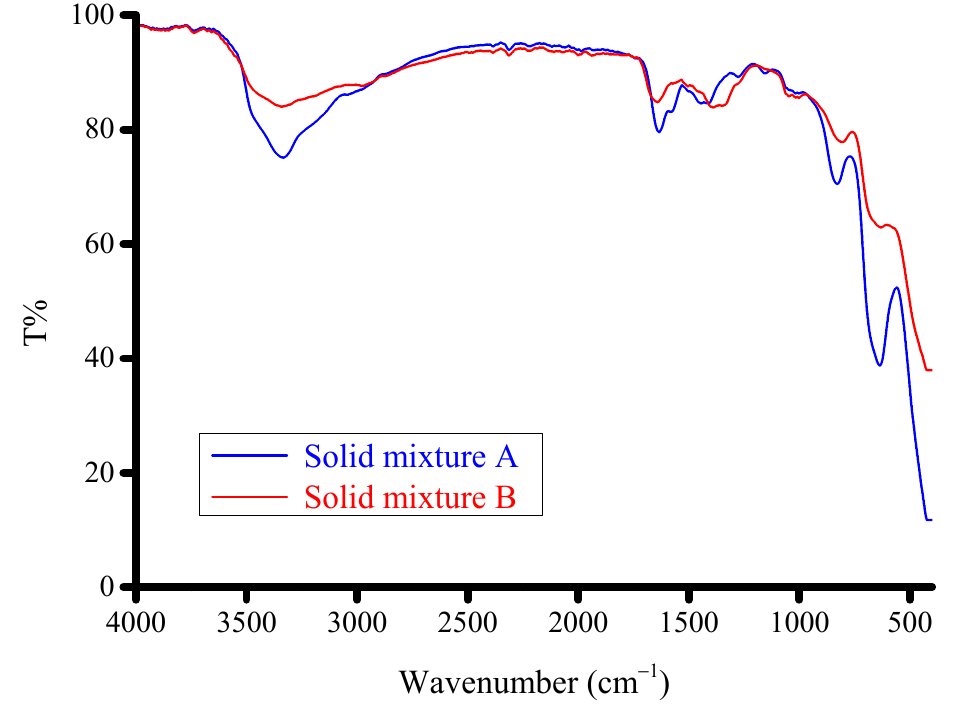
Figure 2. IR spectra of Solid Mixture A ([Fe(NH 2 CONH 2 ) 6 ]Cl 3 and [Cr(NH 2 CONH 2 ) 6 ]Cl 3 ) and Solid Mixture B ([Fe(NH 2 CONH 2 ) 6 ]Cl 3 and [Cr(NH 2 CONH 2 ) 6 ](NO 3 ) 3 ).